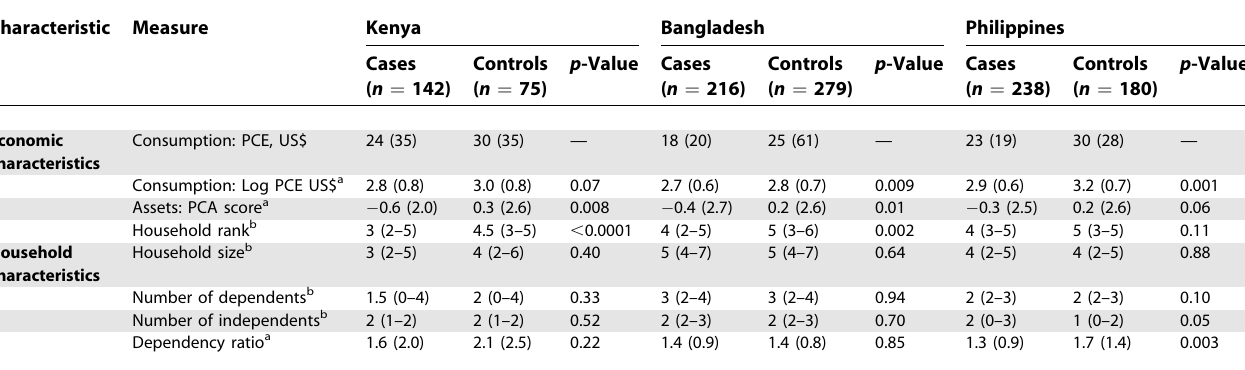
Table 2. Household and Economic Characteristics, for Cases and Controls, in Kenya, Bangladesh, and the Philippines Characteristic